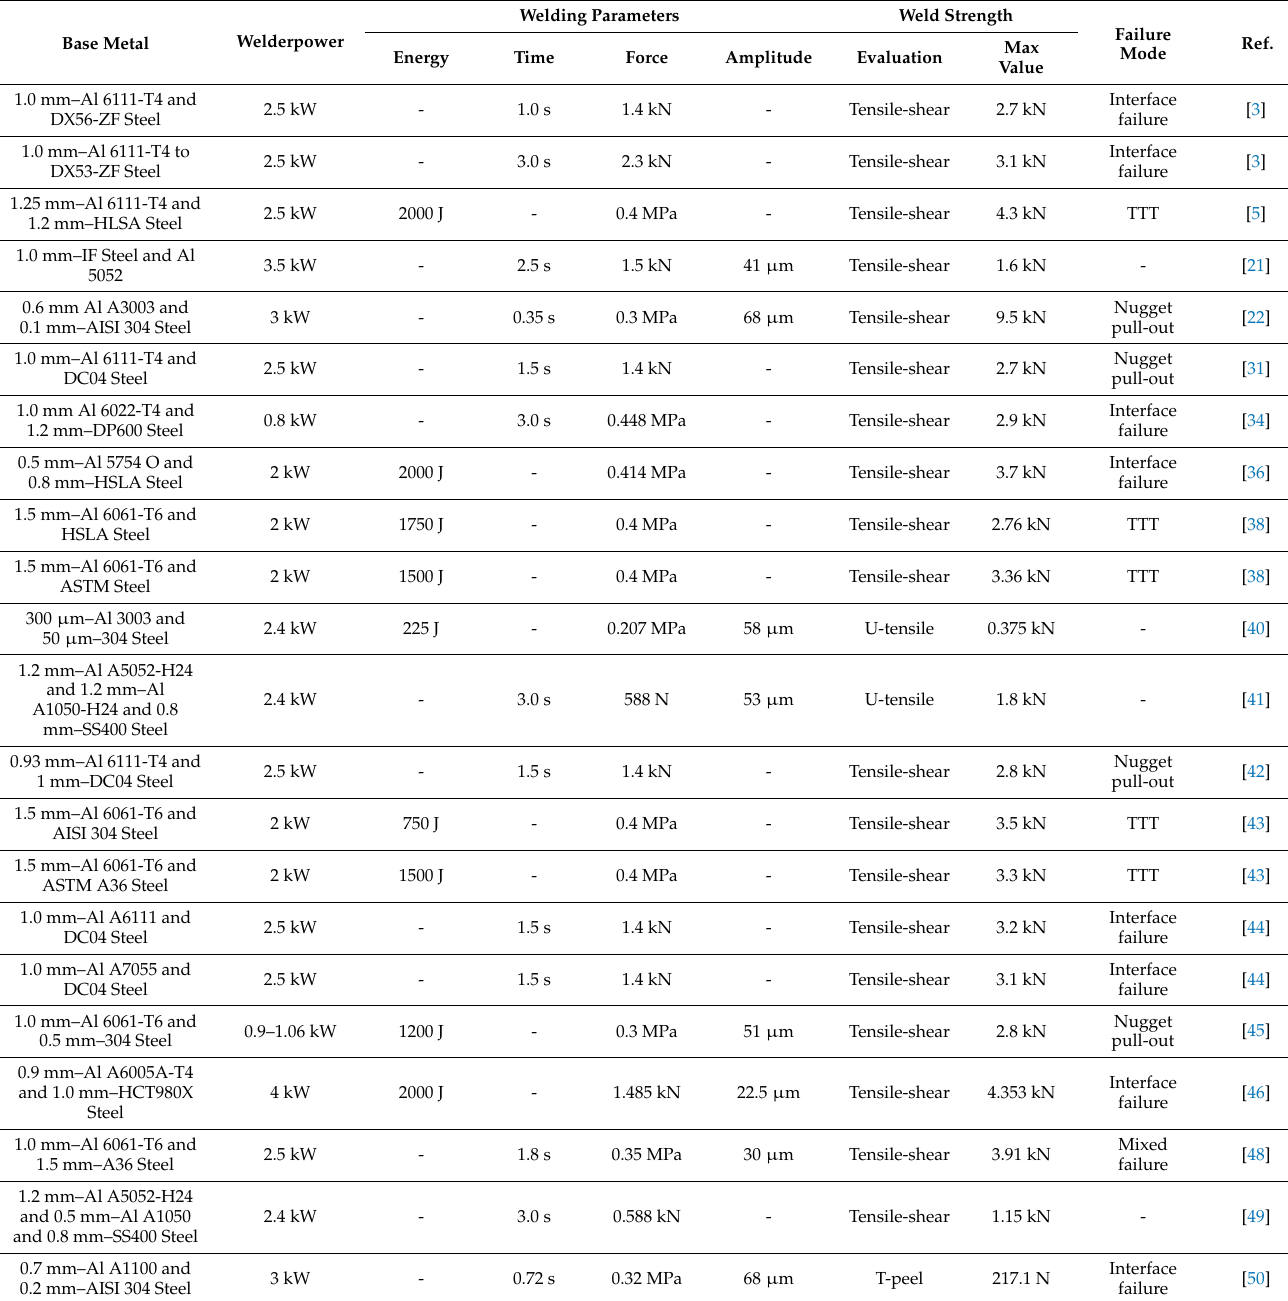
Table 1. Welding strengths of USWed aluminum-to-steel